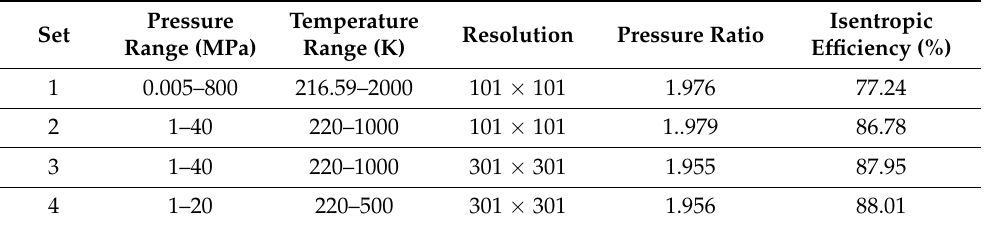
Table 3. Thermophysical property table resolution